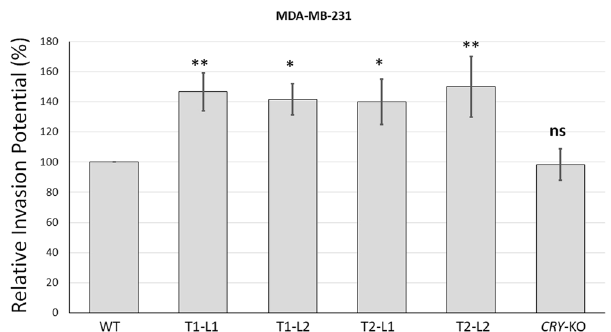
Figure 5. Effect of BMAL1 mutations on MDA-MB-231 cell invasion. Matrigel invasion assay of MDA-MB-231 cells and its knockout subclones were performed using matrigel-coated invasion plates. Cells were seeded at 150,000 cells/well and allowed to invade toward 10% FBS for 36 hours. Invasive cells on the bottom of the invasion membrane were stained (and quickly checked under a microscope) and quantified at OD 560 nm after extraction. There was a similar number of cells in the parent and knockout cell samples. The results of invasion are presented as means ± SD of three independent experiments; SD is denoted by error bars. Invasion was analysed by one-way ANOVA followed by Tukey’s post hoc tests for pairwise comparisons. * P < 0.05, ** P < 0.01, ns; Not significant. KO indicates BMAL1 knockouts generated by T1 or T2 sgRNA targeting, L indicates subclone for each sgRNA